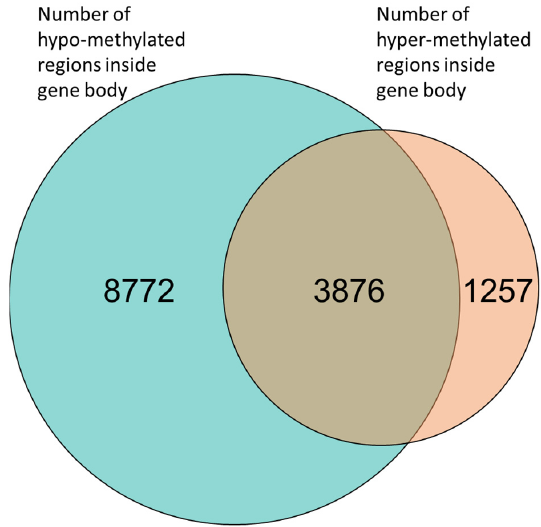
Figure 3. Venn diagram of gene-body methylation. Many genes (3876) had both hyper-methylated and hypo-methylated regions. However, 8772 genes had only hypo-methylation regions and 1257 genes had only hyper-methylated regions.